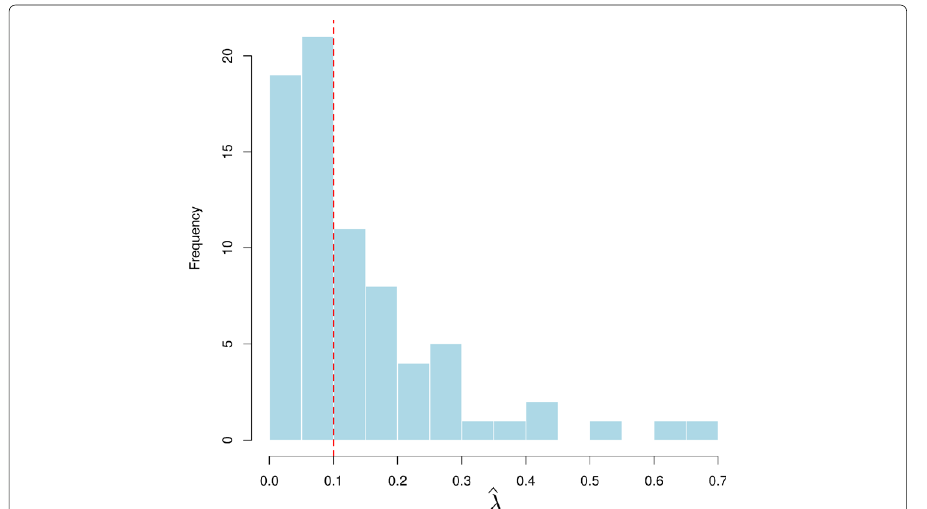
Fig. 7 Distribution of differentiation rate estimates. Histogram of ˆ λ , corresponding to differentiation rates subjected to the penalization procedure. Vertical red dashed line (0.1) highlight the threshold used to select edges included in Fig. 5